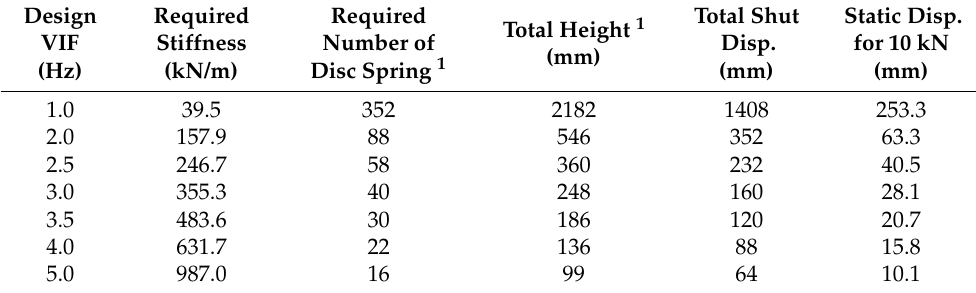
Table 6. Design summary of stacked disc springs for various design VIF.